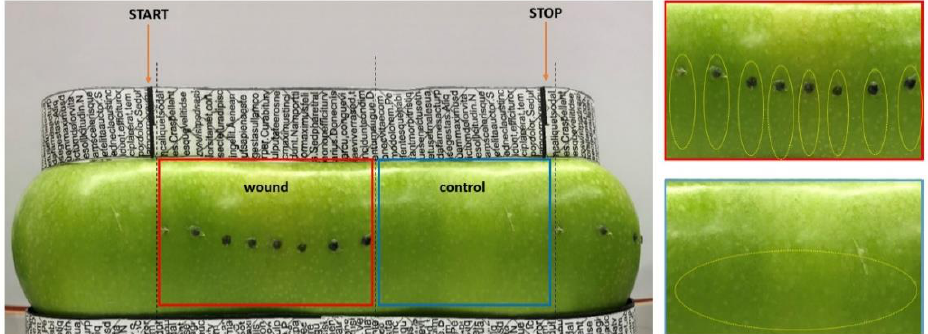
Figure 8. Experimental set-up for the 2D image acquisition of the whole apple surface area and for sampling of material. Wounding sites are evidenced by black spots to allow tracking. The picture was taken by acquiring the entire surface of the fruit by placing it onto a rotating platform and using reference points (evidenced by black boxes and lines located on the adaptor placed on top and bottom sides of the apple), enabling to point the start and end of the image acquisition, as evidenced by orange arrows. By using the reference points the wounded and unwounded (control) halves of the fruits could be precisely separated (evidenced by the boxed areas). This approach allowed acquisition of almost the entire fruit’s surface and for later analysis of the percentage of browned (scalded) versus green areas. On the right of the panel enlarged pictures of the wounded (red box) and of the non-wounded control (blue box) area are shown. The yellow dotted circles indicate the skin area that has been excised for sampling.